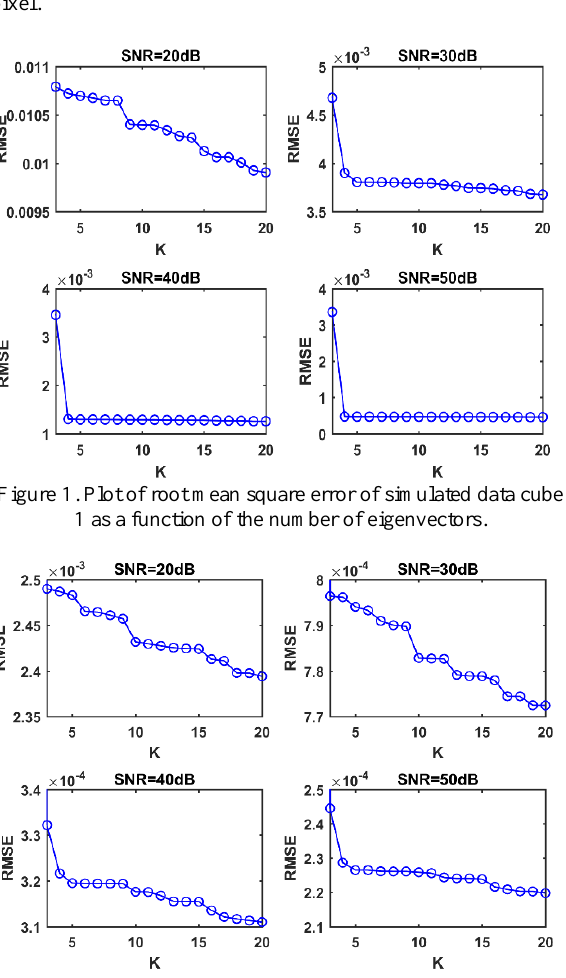
Figure 2. Plot of root mean square error of simulated data cube 2 as a function of the number of eigenvectors in